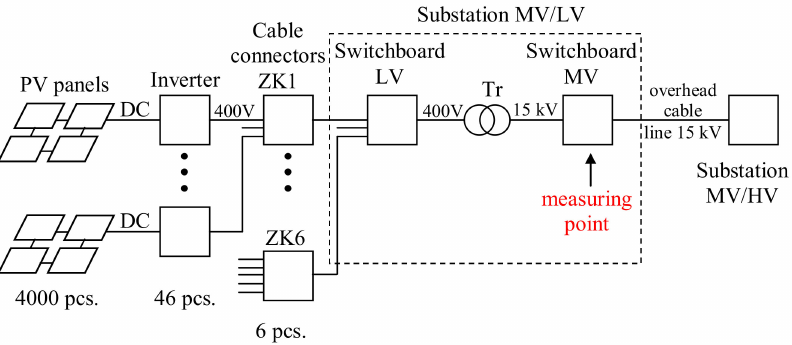
Figure 3. Simplified diagram of the PV power